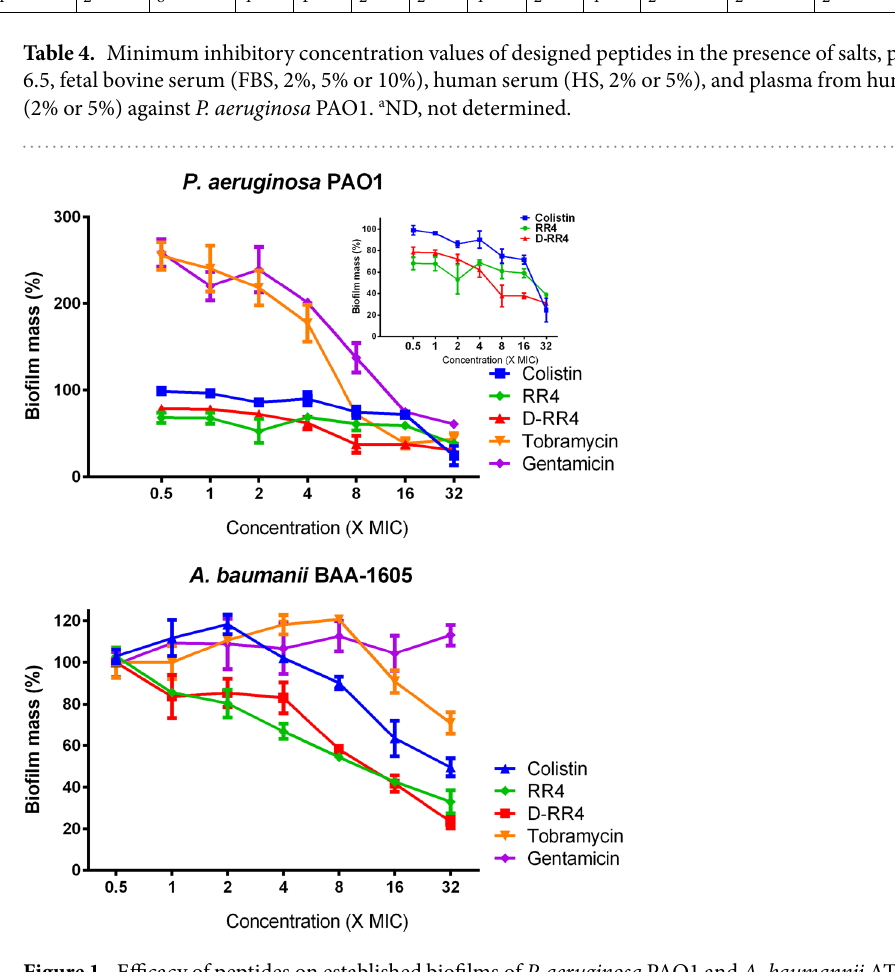
Figure 1. Efficacy of peptides on established biofilms of P. aeruginosa PAO1 and A. baumannii ATCC BAA- 1605. Mature (24 hour) biofilms were treated with different concentrations of RR4, D-RR4, colistin, tobramycin and gentamicin for 24 hours at 37 °C. After incubation, wells were washed and biofilms were stained with 0.5% (w/v) crystal violet for 30 minutes. The dye was solubilized with ethanol (95%) and the optical density (595 nm) of the biofilm mass was measured. Experiments were repeated twice independently and the average values are